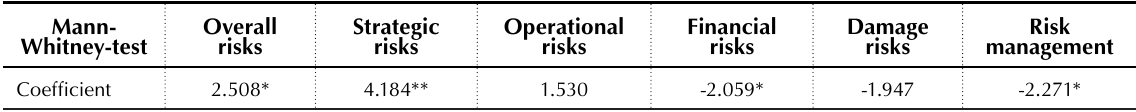
Table 10. Mann-Whitney test of corporate risk disclosure indices of UAE conventional and Islamic banks Mann-